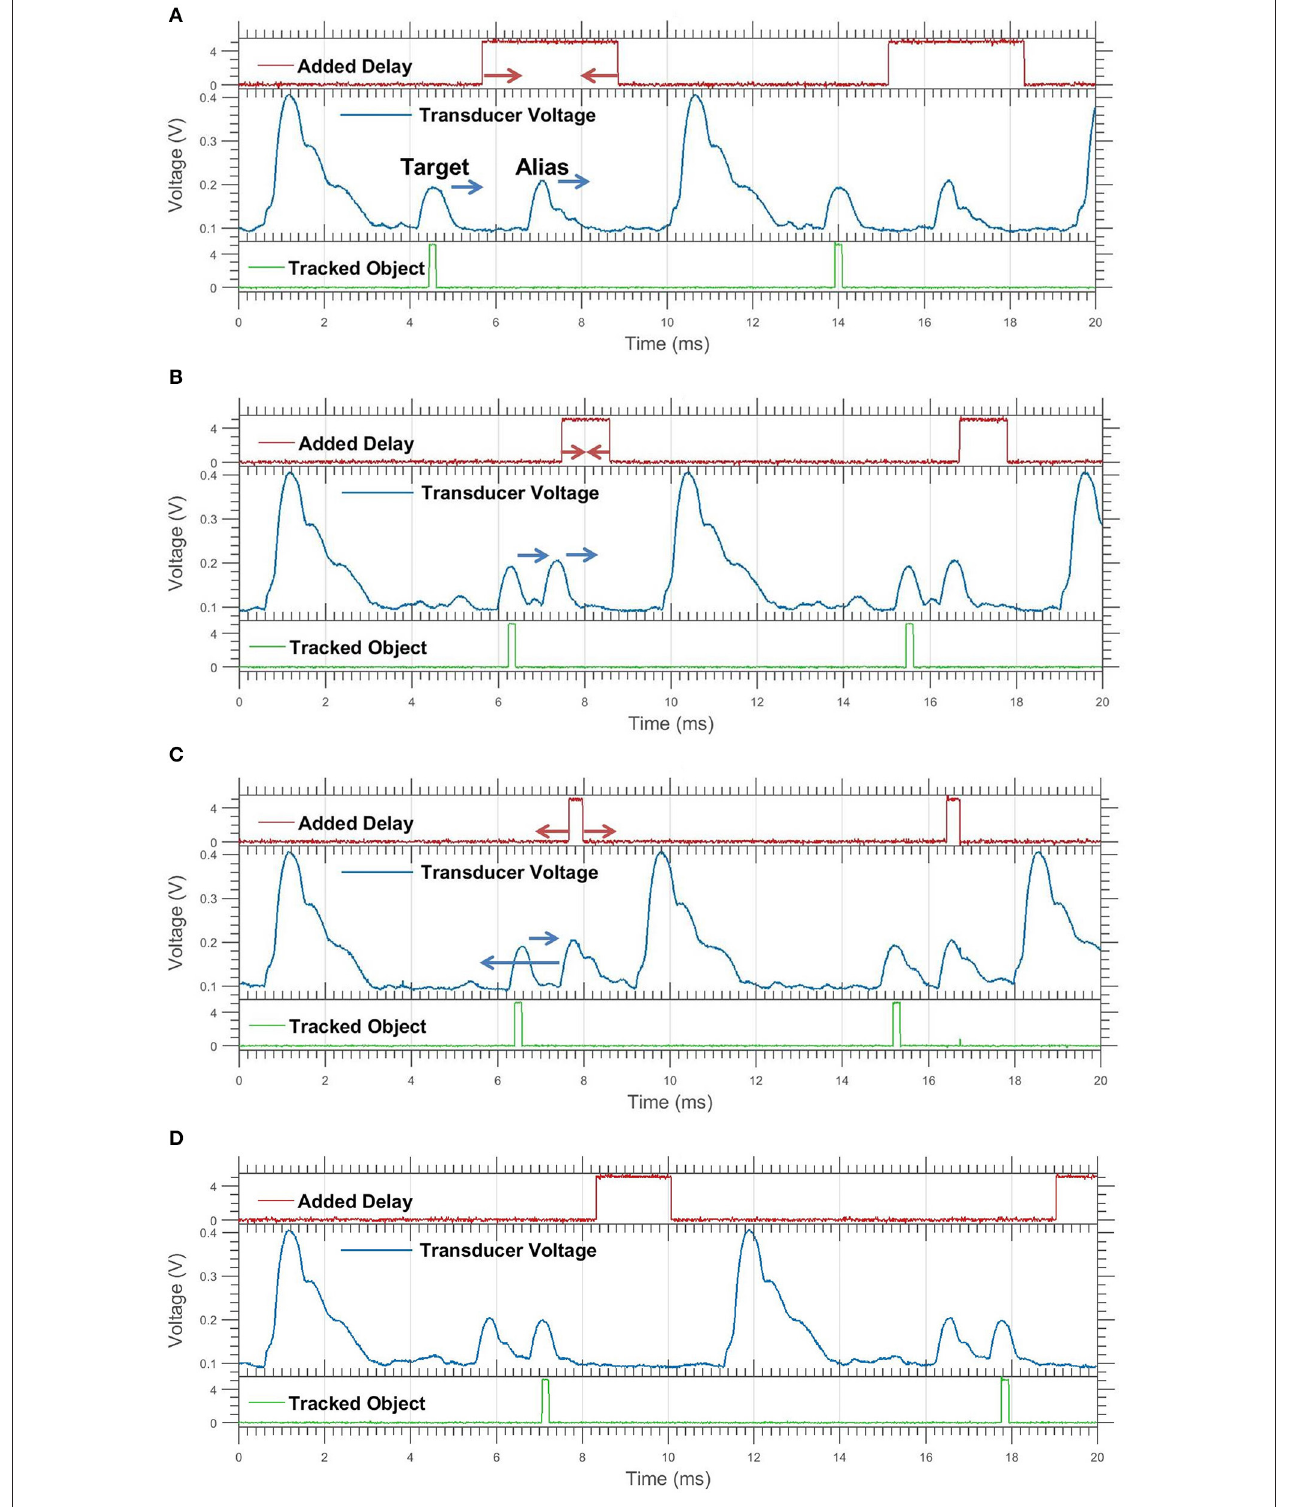
FIGURE 7 | Continuation of Figure 6 for a retreating target. (A,B) The target moves back; the alias is pushed back by the decreasing delay. (B,C) Both echoes continue backwards, the delay buffer reaches its minimum value. (C,D) The delay buffer jumps upwards, causing the alias to jump forwards in front of the target.